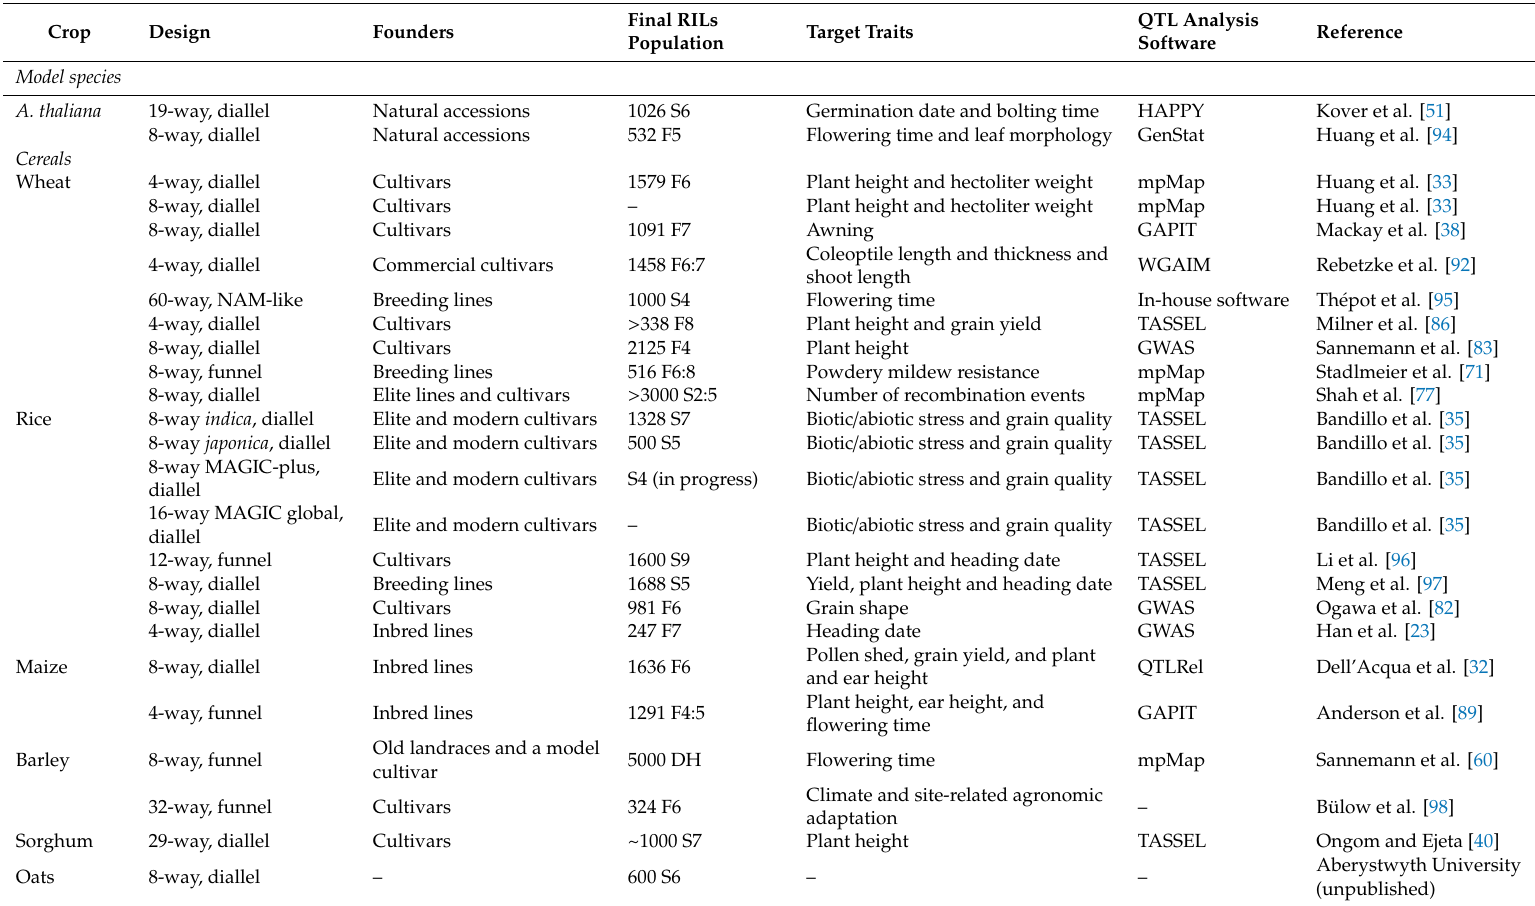
Table 2. Current status of available MAGIC populations in the model species Arabidopsis thaliana and in crop plants, including the cross-design, founders, number of RILs in the MAGIC populations, target traits, and software analysis used for QTL